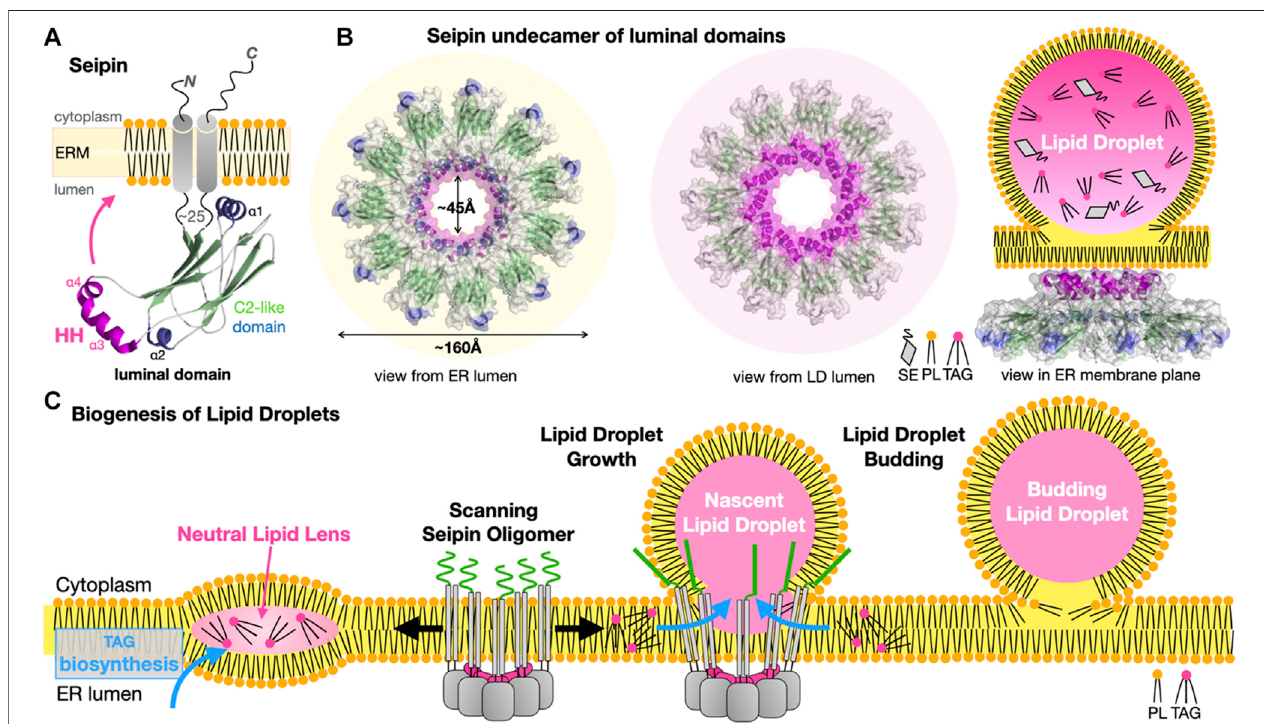
FIGURE 11 | Seipins at the Endoplasmic Reticulum-Lipid Droplet interface. (A) Structure of the Hs / Dm seipin monomers. Two transmembrane helices anchor a luminal domain to the ER. The evolutionarily conserved β -sandwich domain (or C2-like) contains a membrane-anchoring hydrophobic helical (HH) insertion (magenta). (B) Undecamer of Hs -seipin ( Dm forms similar dodecamers) shown in transparent surface representation highlighting the luminal HH α -helices involved in ERanchoring. ThreeviewsfromtheERandLDlumensand,sidewaysintheERmembraneplane,areshowntoemphasizethecup-orfunnel-shapedstructureandlikelymodeof membrane association of the seipin oligomers on the ER-luminal side of a nascent LD. Secondary structure elements are colored the same way in (A, B) . (C) Model for thebiogenesisoflipiddropletsfromtheirnucleationtotheirgrowth.Oligomersofseipin(grey)scantheERmembranelateralplaneforthepresenceofneutrallipidlenses. TheHHmotifs(magenta)actsasascaffoldregulatingthesurfacetensionwhiletheN-terminalextensions(green)furtherstabilizetheseipin-nascentLDMCS.Theluminal domain of seipin facilitates the lateral transfer of TAGs to the growing LD (PDB 6MLU-6DS5 EMD-9146 EMD-8909).